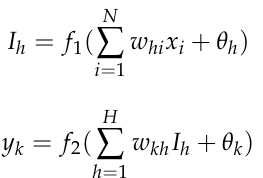
Figure 6 is the design flow chart of the multi-objective antenna based on MISSA-BP.